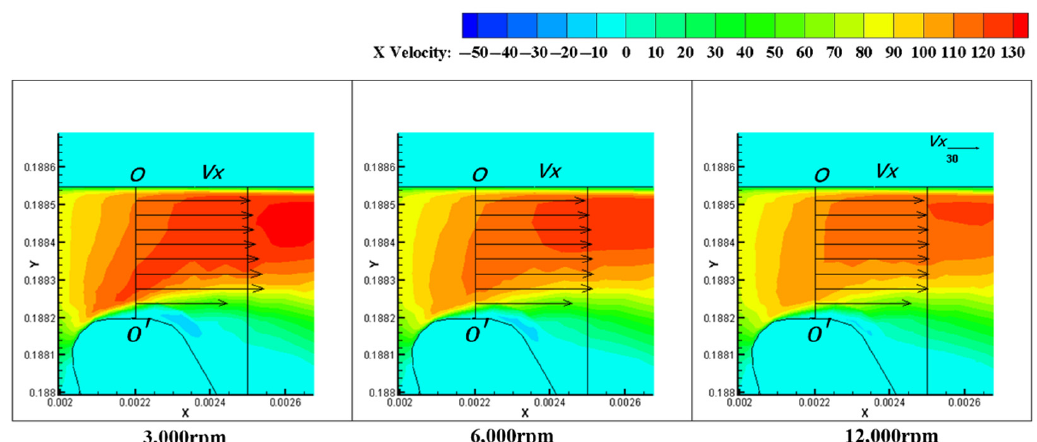
Figure 8. Comparison of axial velocities in the fluid domain of labyrinth clearance.